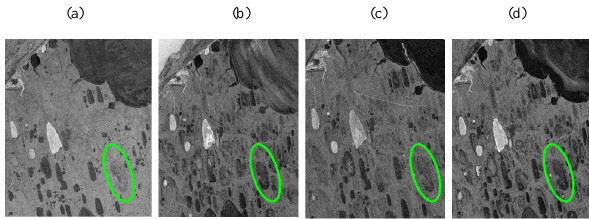
Fig. 8. Late winter (April/May) differences in radar returns Figure 8. Late winter (April/May) differences in radar returns from Sikulik Lake – (a) 1992; (b) 2000; (c) 2001; (d) 2002. 810